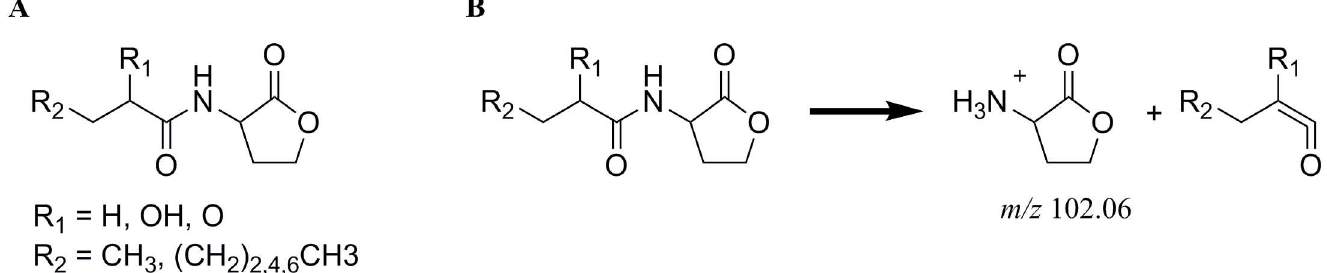
Fig 1. Structural formulas and MS/MS fragmentation of AHLs. (A) Structural formulas of AHLs produced by P . aurantiaca PB-St2. (B) Fragmentation of AHLs into the [M+H] + ion of the lactone moiety in the